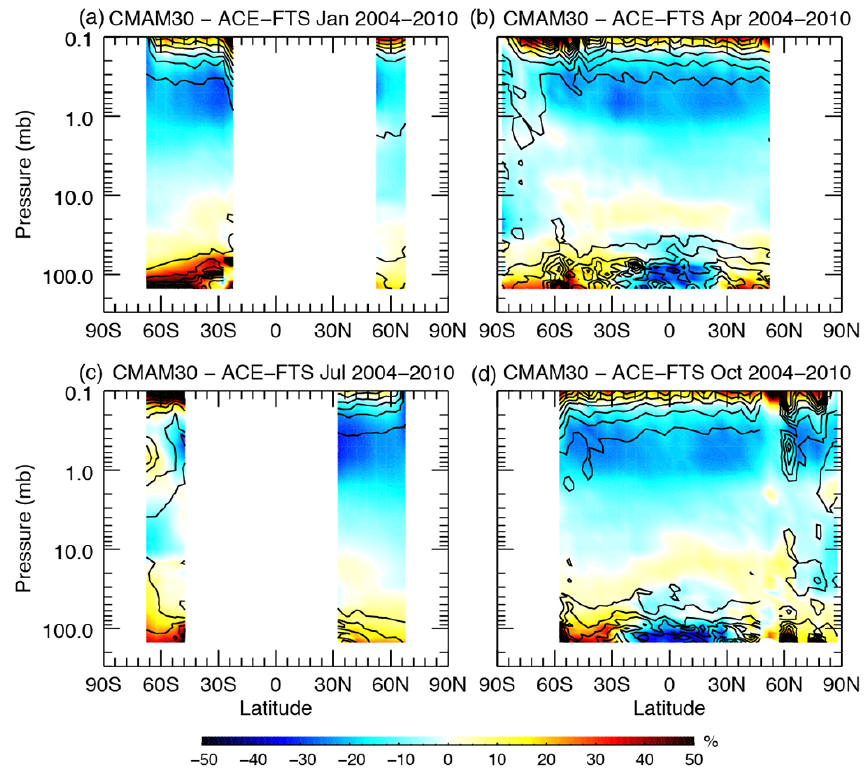
Figure 3. Same as for Fig. 1 but for CMAM30 vs. ACE-FTS absolute temperature differences for 2004 to 2010 for January (a) , April (b) , July, (c) and October (d) . Note that the vertical axis here is